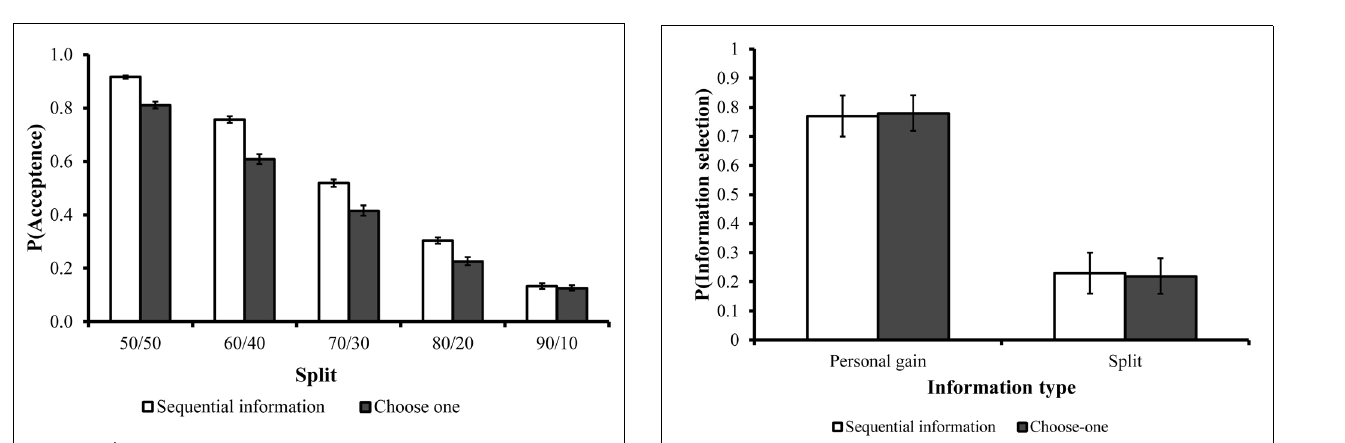
long as the response time based on examining the absolute value of the offer alone [1.2 s, SD = 0.4; F (1,9) = 6.868, p < 0.05]. Short response times are assumed to reflect reliance on instantly accessible information whereas long response times indicate more deliberate cognitive consideration (Ayal and Hochman,